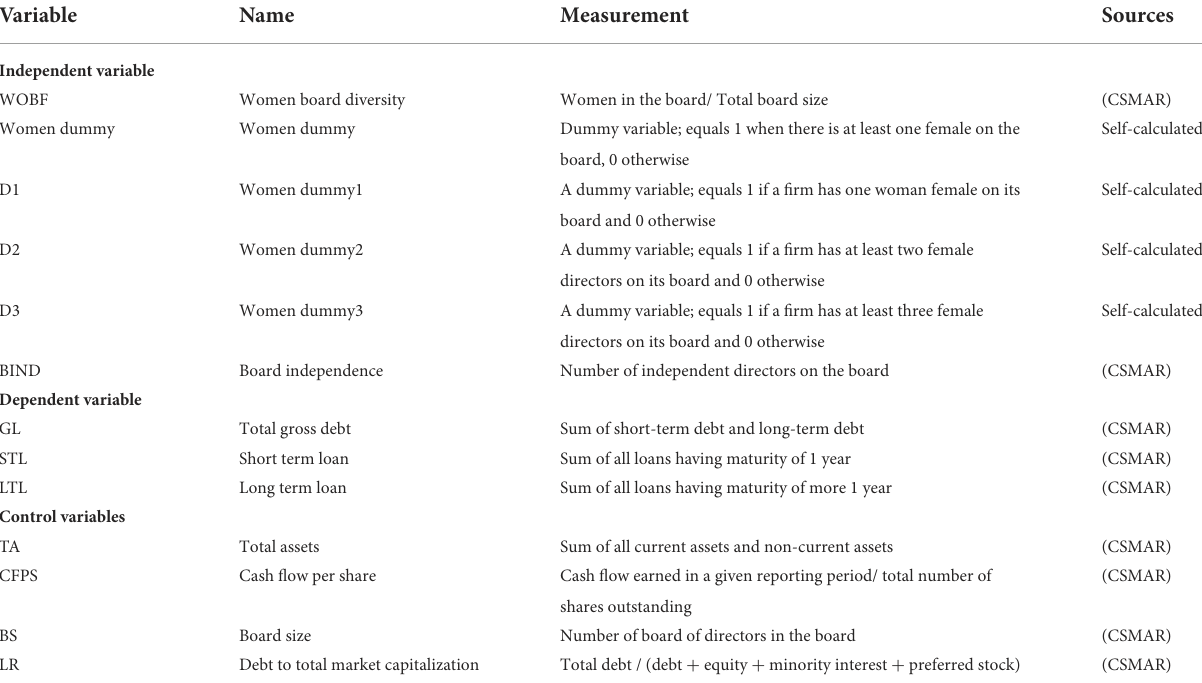
TABLE 1 Variables description and